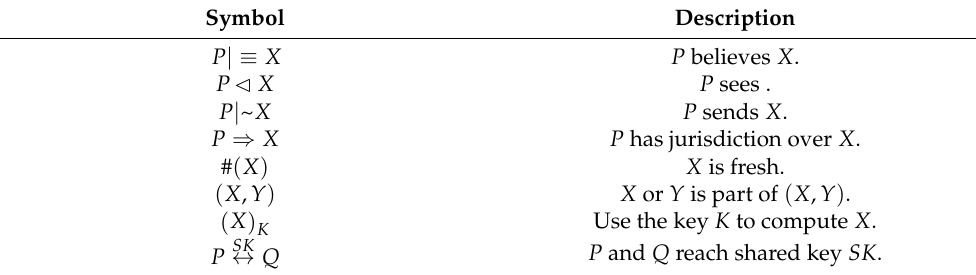
Table 4. BAN -logic notations.